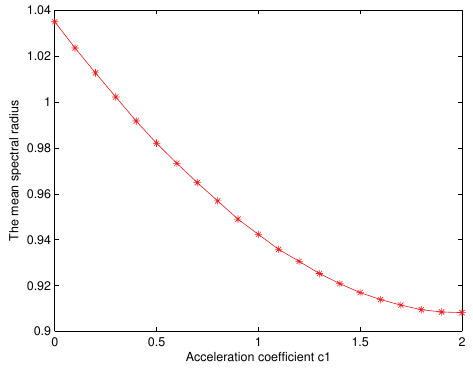
Figure 9: Mean ( (cid:7) ) under c 1 = c 2 . Figure 10: Mean ( (cid:7) ) under c 1 + c 2 = 4 .